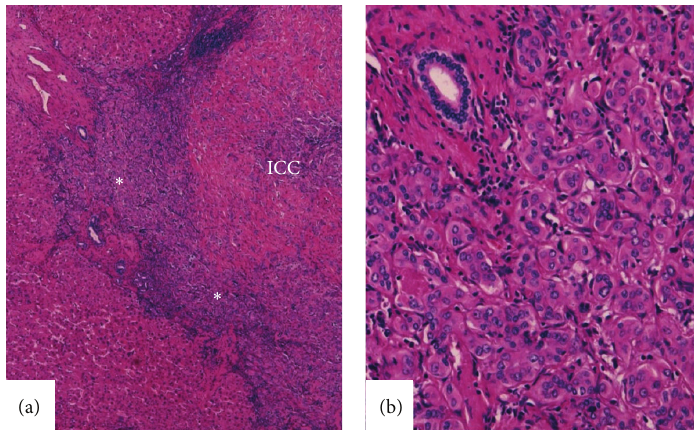
Figure 7: At the periphery ( ∗ ) of intrahepatic cholangiocarcinoma (ICC), there is well-differentiated lesion or bile duct adenoma-like lesion. (a) Lower magnification of ICC and (b) higher magnification of the rim ( ∗ ).